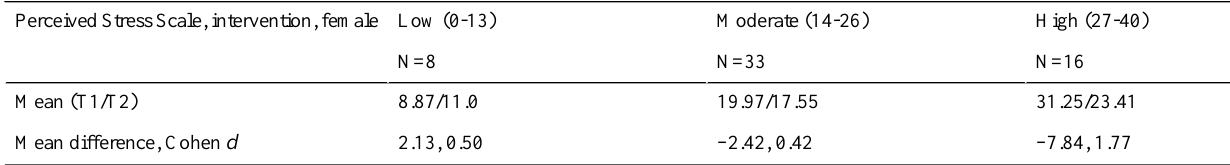
Table 15. Analysis of Perceived Stress Scale categories: female.